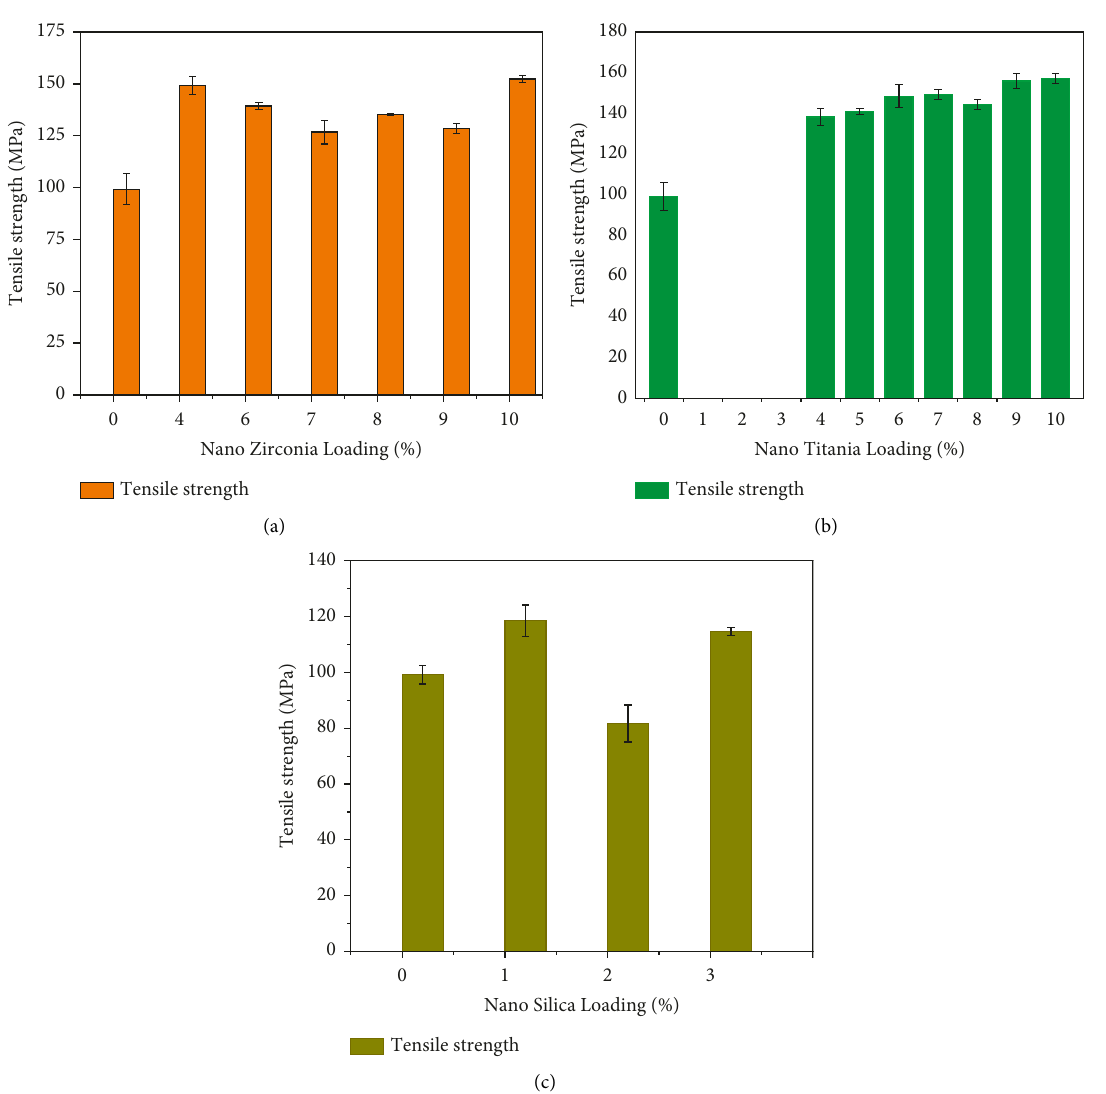
Figure 6: Tensile strength variation with the nanofiller loading. (a) Zr-C-Ph laminate, (b) Ti-C-Ph laminate, and (c) Si-C-Ph